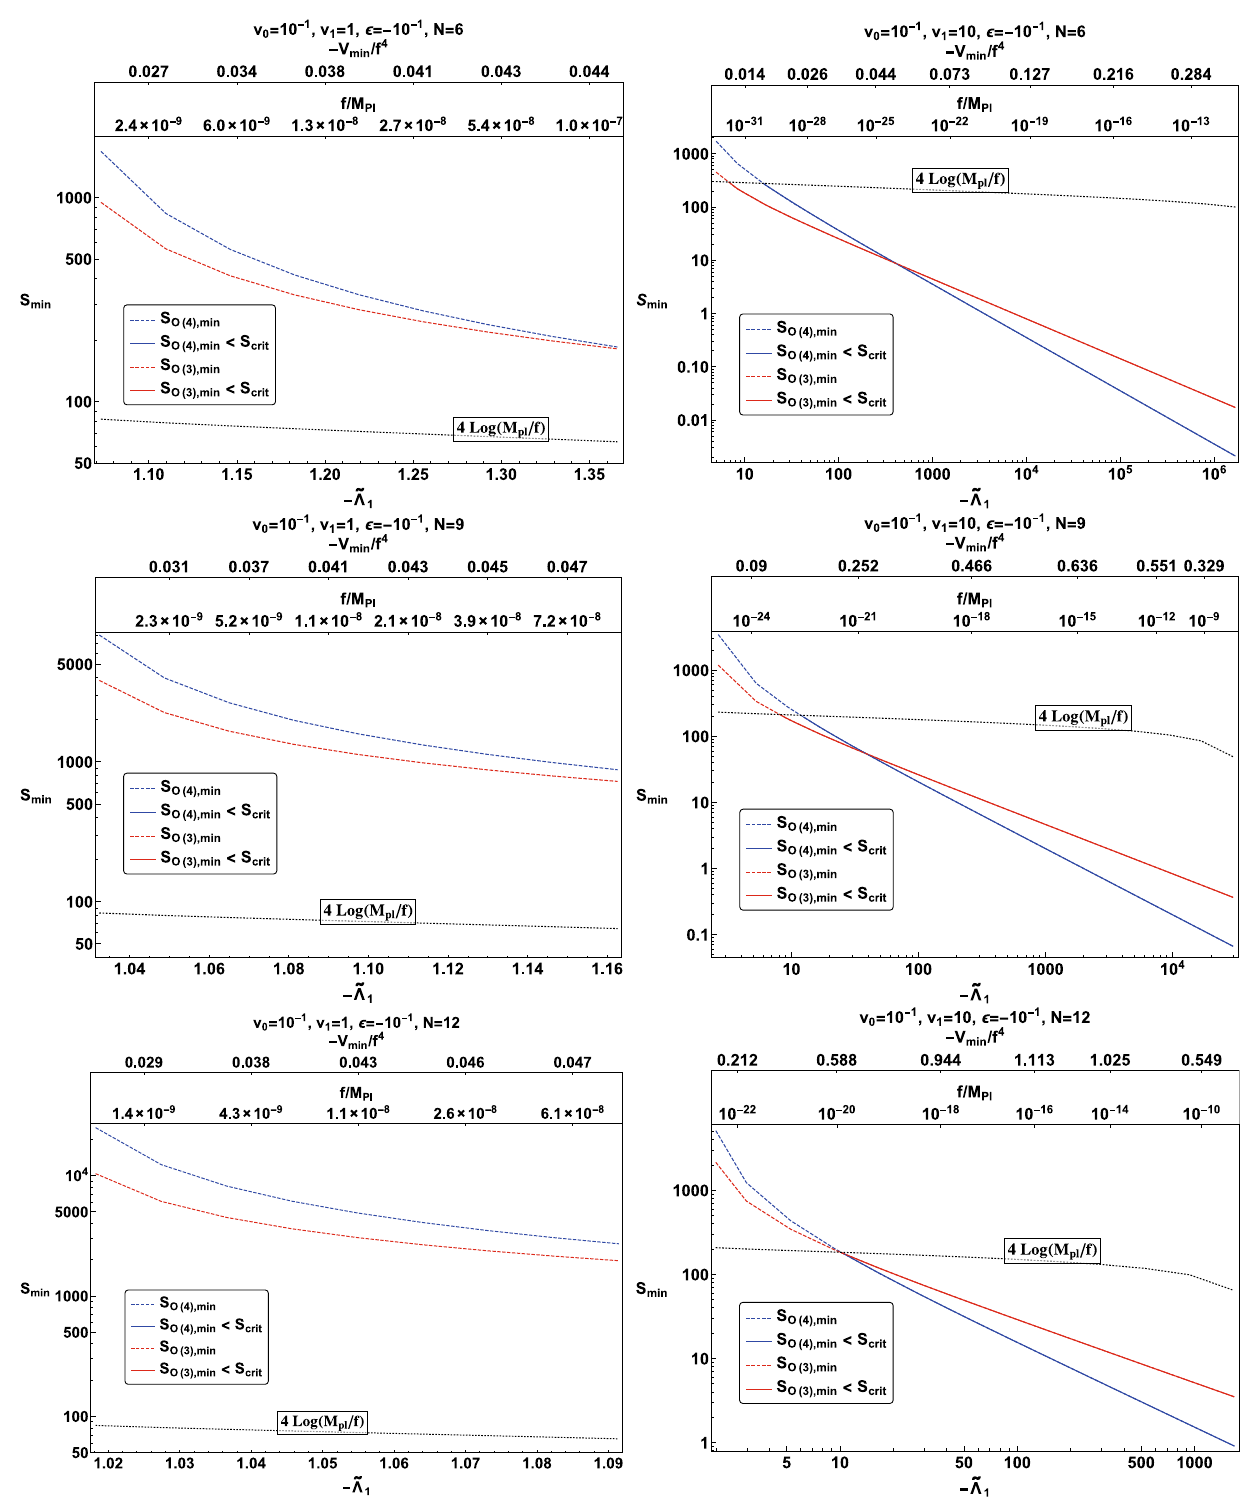
Fig. 5 Each panel includes plots of the values for the O ( 3 ) and O ( 4 ) symmetric bubble actions as a function of the dimensionless IR brane tension (cid:7) (cid:10) 1 . The critical value for the action as a function of f / M Pl is